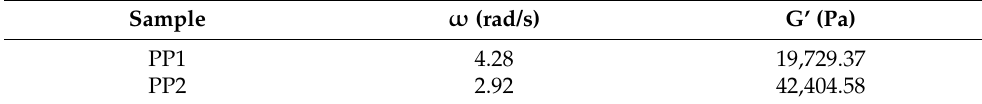
Table 2. Angular frequency ( ω ) and storage modulus (G’) at the intersection of modulus curves. Sample